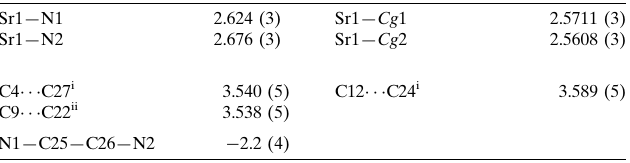
Selected geometric parameters (A˚ , (cid:3)